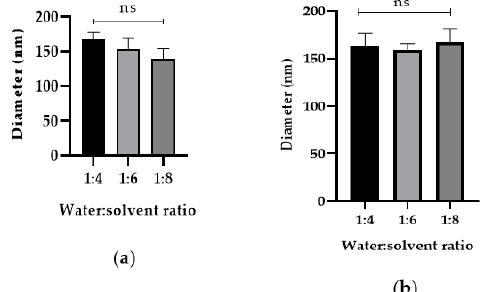
Figure 4. Increased addition of co-solvent during nanoprecipitation does not affect Cyt c NP diameter. Cyt c NPs were obtained by adding three different ratios of DI water-to-acetonitrile (1:4, 1:6, and 1:8) with two different starting Cyt c concentrations: a ) 2.5 mg/mL, left panel and b ) 5 mg/mL, right panel. One-way ANOVA tests were not significant among all conditions. Data are the averages of three preparations, and the error bars show the SD.